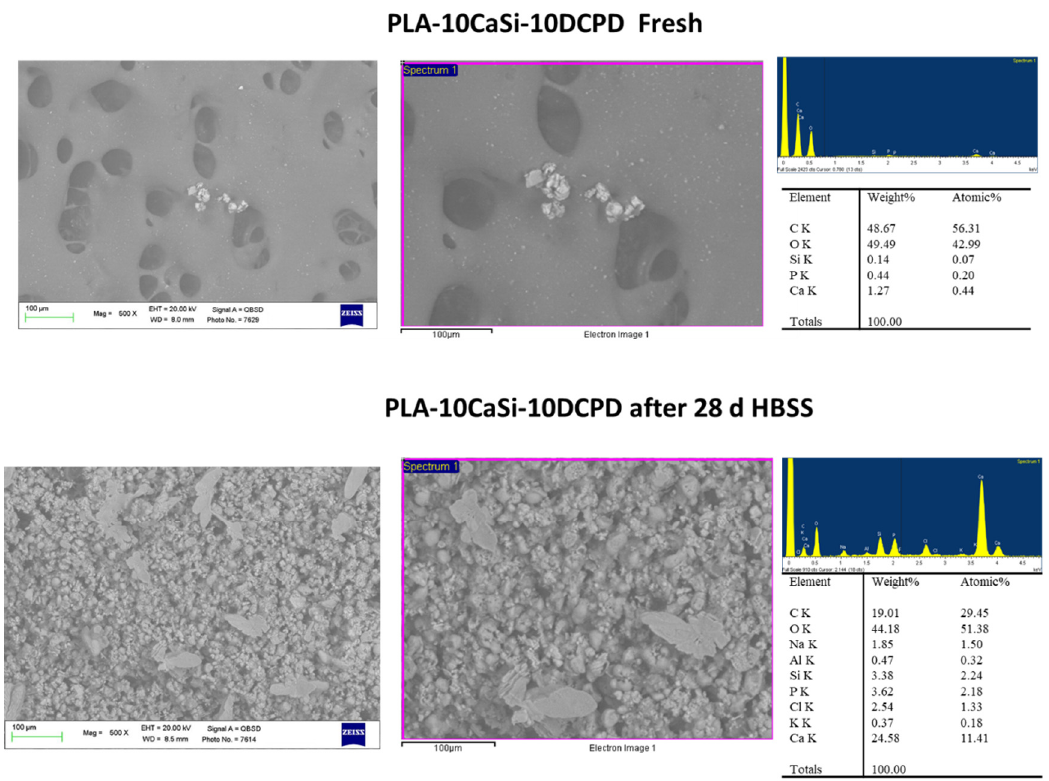
Figure 2. Surface micromorphology of PLA-10CaSi-10DCPD before and after 28 days immersion in simulated body fluid (500×–1000× magnification); pores of different size (diameter range between 20 and 100 µm) were observed: CaSi and dicalcium phosphate dihydrate (DCPD) microgranules are diffused onto all the structure. In some areas, agglomeration of these granules were also observed. Samples soaked in HBSS for 28 days revealed a well-evident electron dense mineral layer on the materials with pores of approx. 100 µm diameter filled by this layer. Energy dispersive X-ray (EDX) microanalysis on samples not immersed in HBSS showed the polylactic acid (PLA) structural peaks (C and O) and low traces of mineral filler constitutional peaks (Ca, Si, and P); EDX revealed after 28-day immersion in simulated body fluid a consistent decrease of C (from PLA matrix), and a significant elevation of Ca, Si, and P.